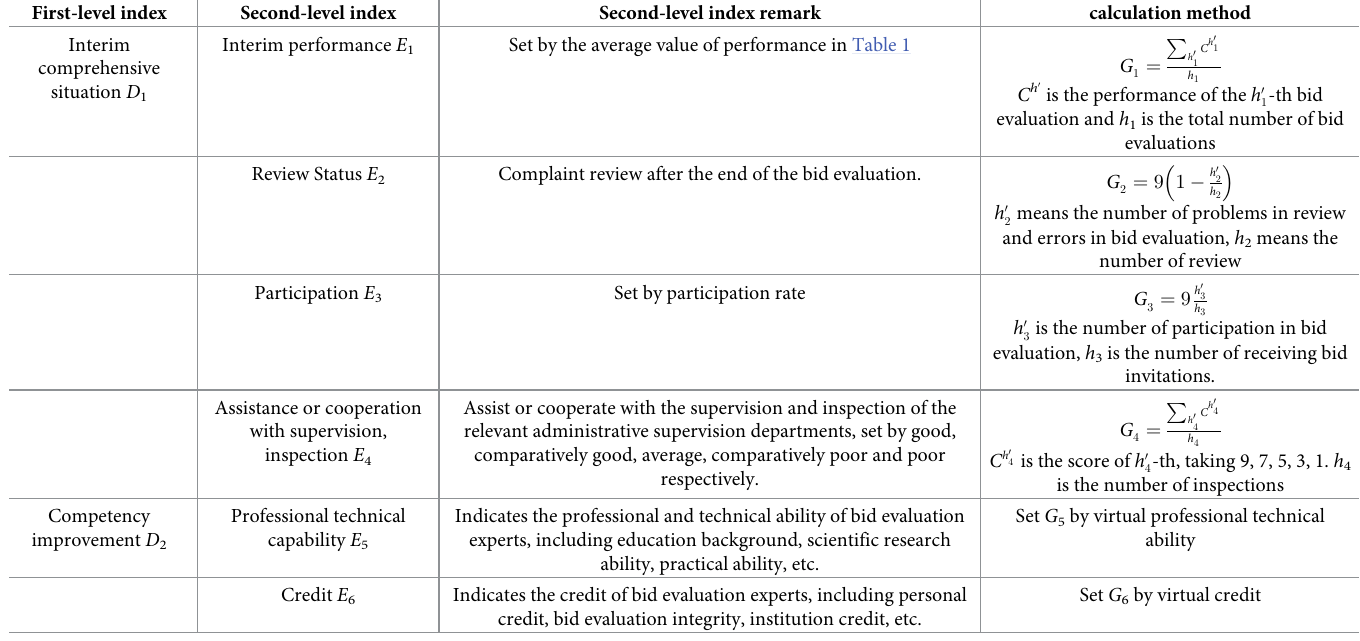
Table 2. Evaluation index system of dynamic